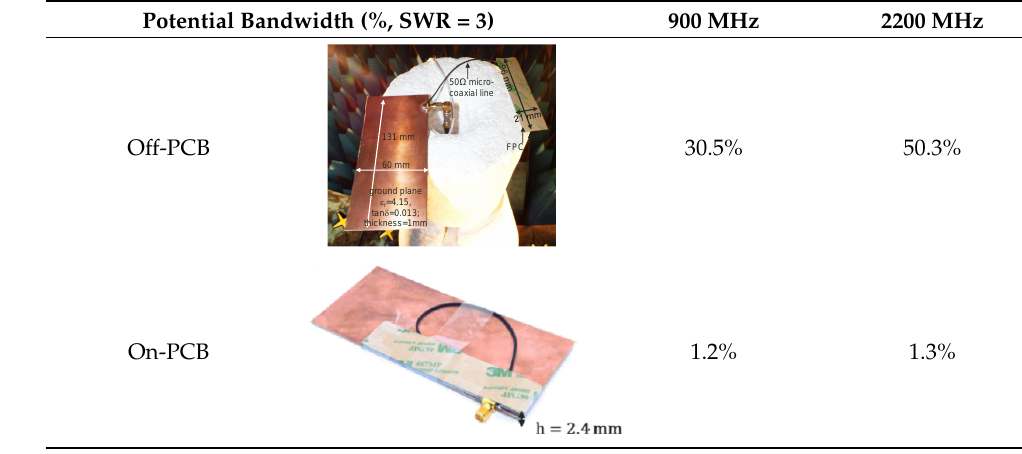
Table 8. Potential bandwidth for the FPC antenna for off-PCB and on-PCB.